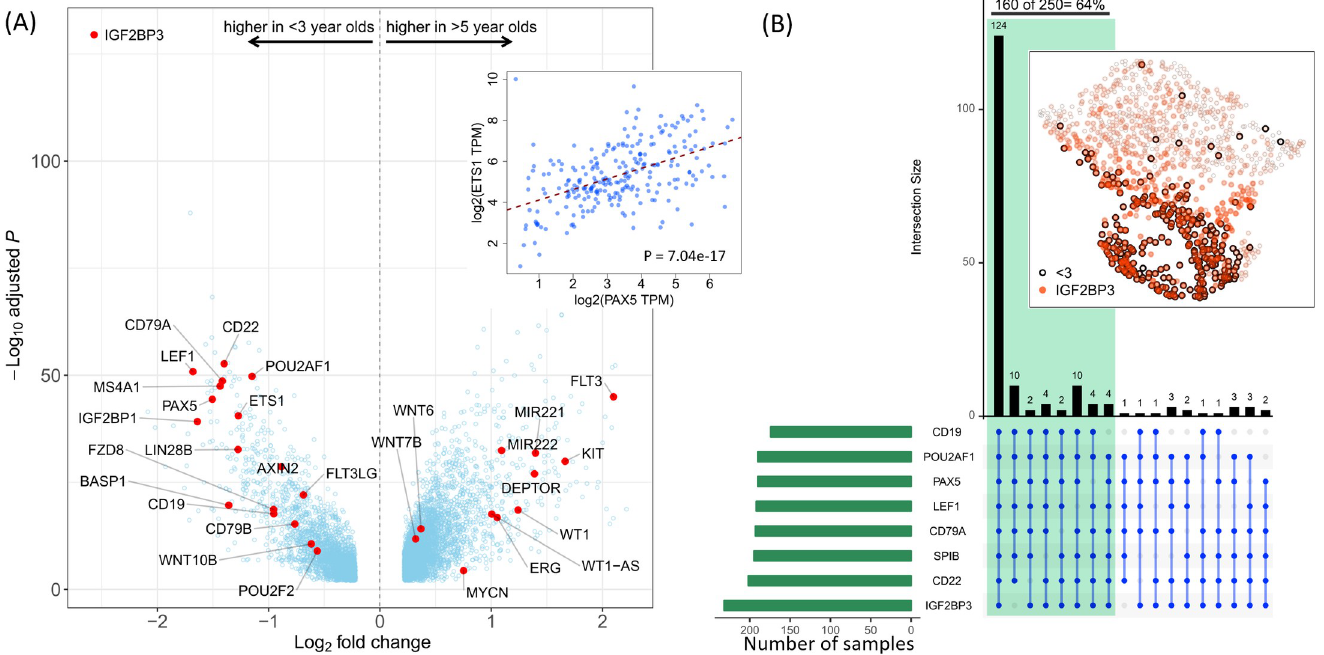
Fig 2. Many B cell specific genes are differentially expressed genes in infant AML. ( A ) Volcano plot showing–log10(adjusted p-value) and log2(fold change) of genes differentially expressed between infant AML (n = 250) and AML in children > 5 years old (n = 706). Genes to the left of the plot are up-regulated in infant AML compared to AML > 5 year olds. Genes to the right of the plot are down-regulated in infant AML. Some notable genes are labeled individually. Canonical WNT signaling genes WNT10B , FZD6 , LEF1 , and AXIN2 are up-regulated in infant AML, as are the transcription factor ETS1 and a large number of B-cell genes. In contrast, the AML associated genes KIT , FLT3 , and WT1 are down-regulated in infants compared to children > 5 years old. The inset shows a high correlation between the B-cell marker PAX5 , and its transcriptional co-activator ETS1 . ( B ) A group of eight B-cell associated infant AML genes (listed at bottom-left) are expressed at above average (total cohort size = 1,038) levels in ~ 64% of infant AML (marked by the green shaded area). For each gene, green bars at left show the numbers of infant AML cases with above average expression. Connected blue disks below the top bar plot indicate combinations of genes and the corresponding black bars indicate the number of samples over-expressing that combination of genes. Inset shows a 2-dimensional UMAP projection of the expression data, in which each point represents the expression profile of one sample for the eight genes. Infants are marked by a black circle, and intensity of red indicates the expression level of IGF2BP3 per